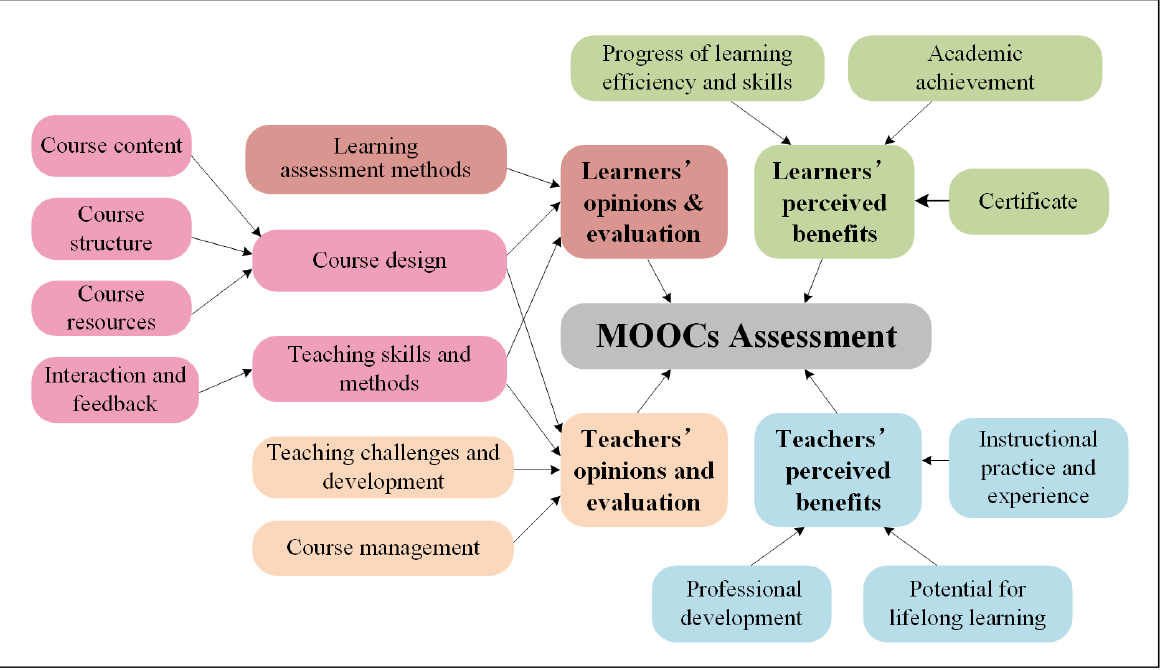
Figure 3 F-G Graph: Factors for Assessment of